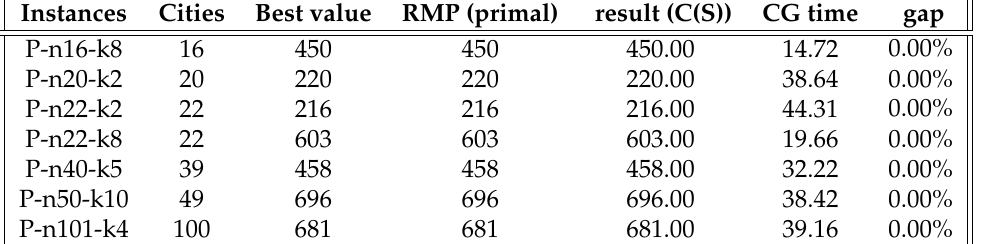
Table 2. Column generation result